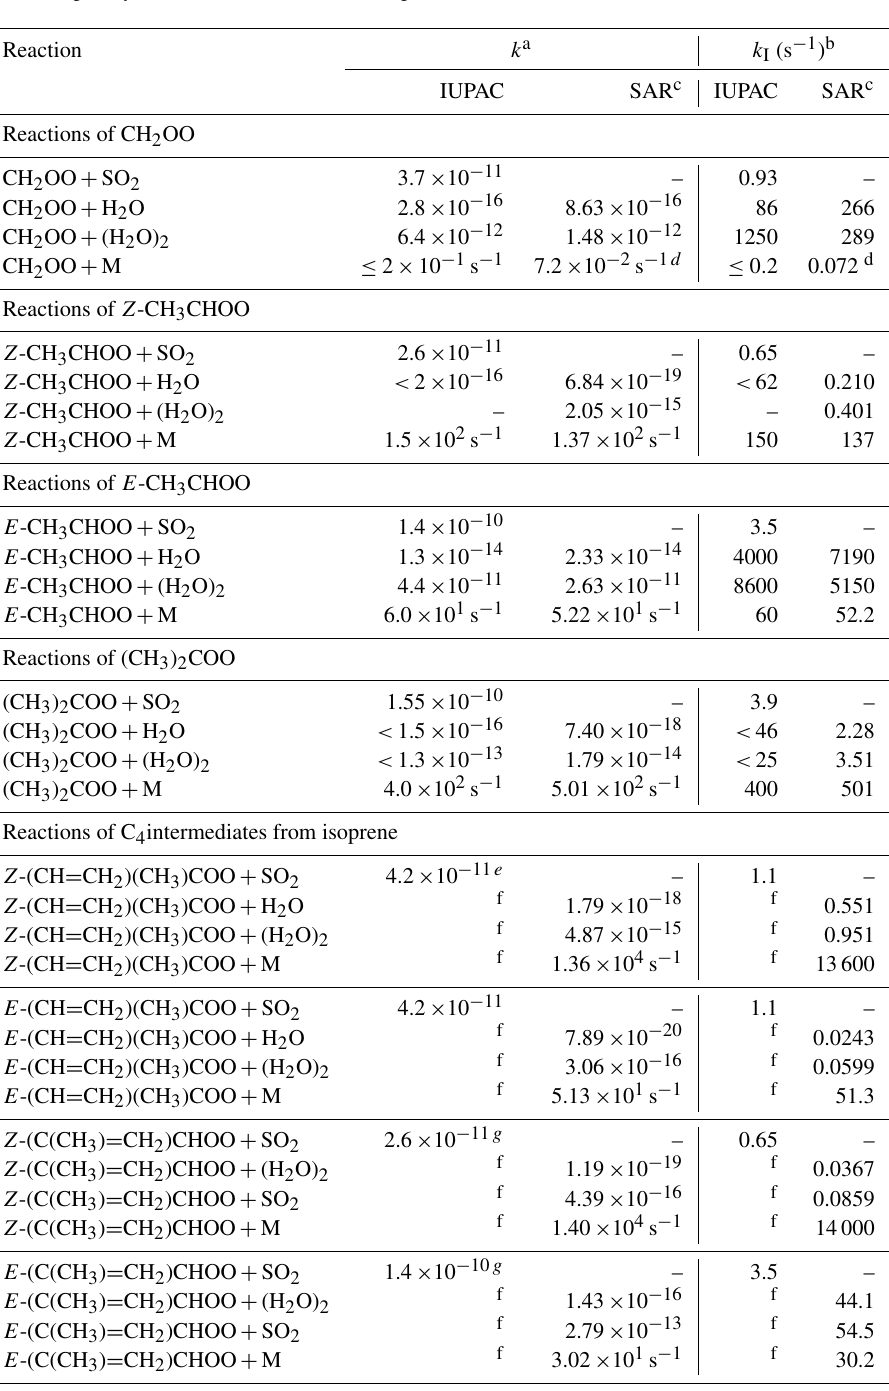
Table 7. Rate coefficients ( k ) and representative lower tropospheric first-order loss rates ( k I ) at 298K for sCI bimolecular reactions with SO 2 , H 2 O and (H 2 O) 2 , and unimolecular decomposition. The present recommendations (IUPAC) are compared with calculated values using the theory-based SAR developed by Vereecken et al. (2017) (except where